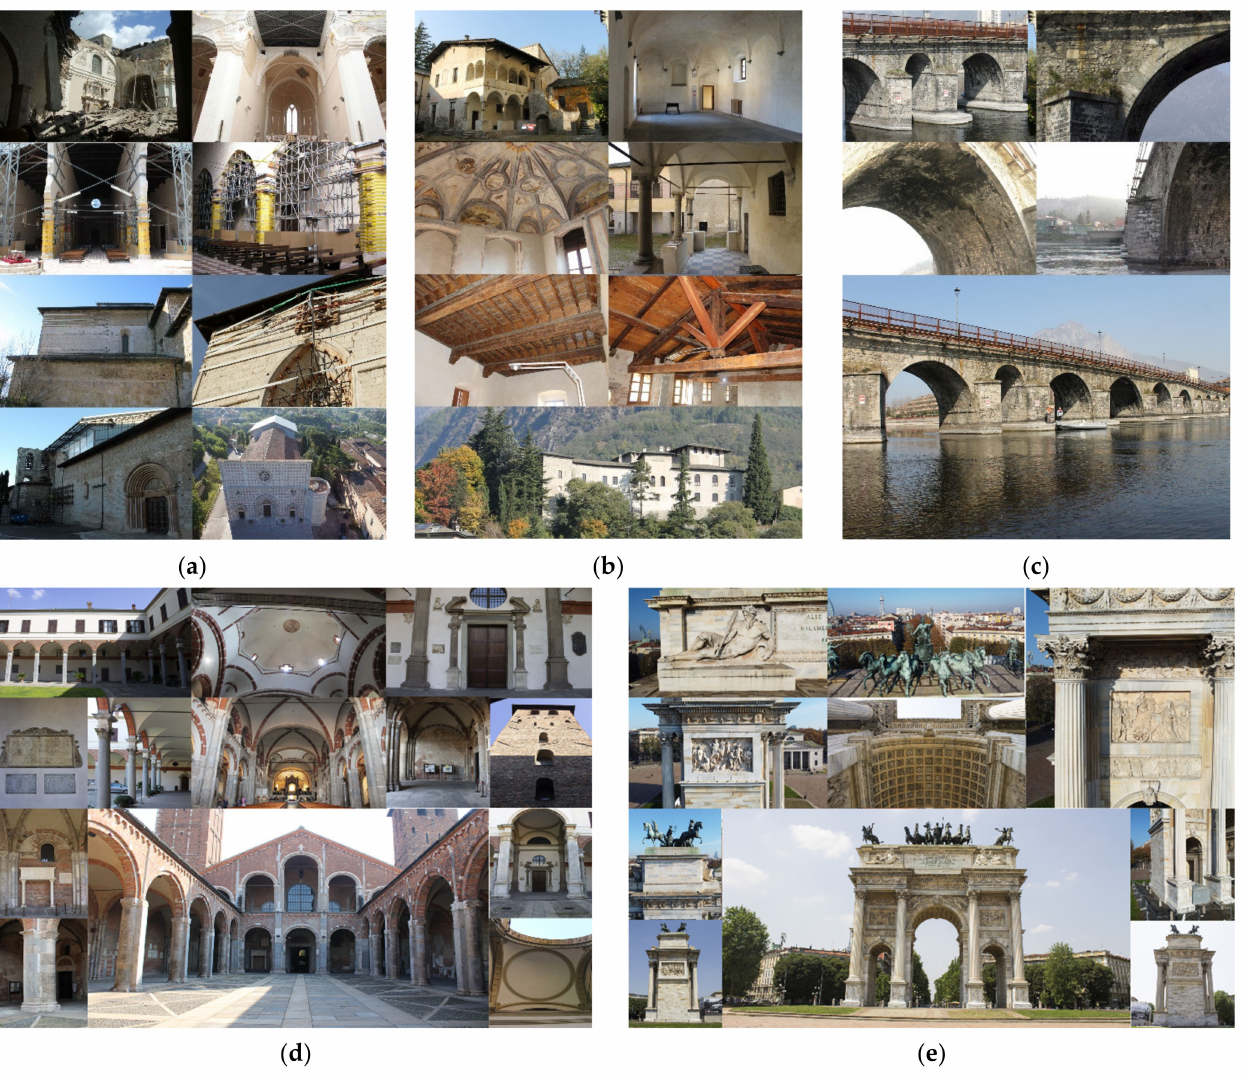
Figure 8. Italian research case studies: ( a ) Basilica di Collemaggio (L’Aquila), ( b ) Masegra Castle (Sondrio), ( c ) Azzone Visconti Bridge (Lecco), ( d ) Basilica di Sant’Ambrogio and ( e ) Arco della Pace (and their architectural